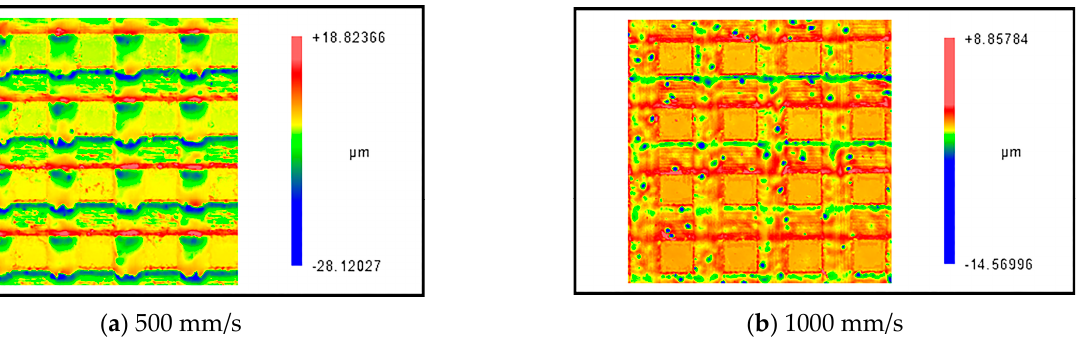
Figure 9. Experimental results of laser processing at different scanning speeds (Average power = 8 W, pulse width = 40 ns, frequency = 150 kHz).